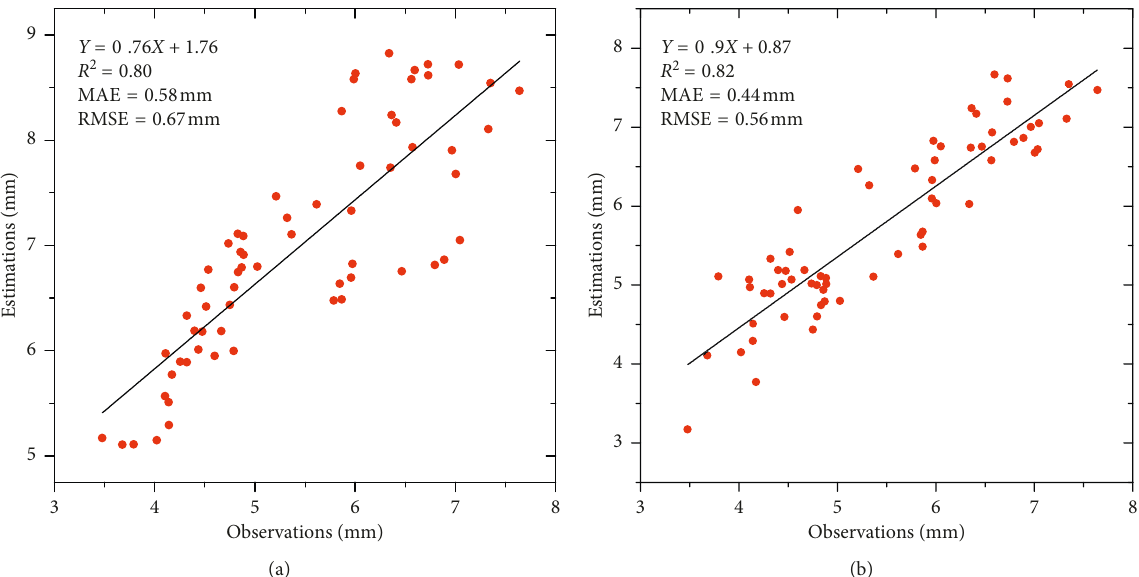
Figure 9: Comparison between daily ETobserved by EC stations and that estimated by the sine function method (a) and the ETrF method